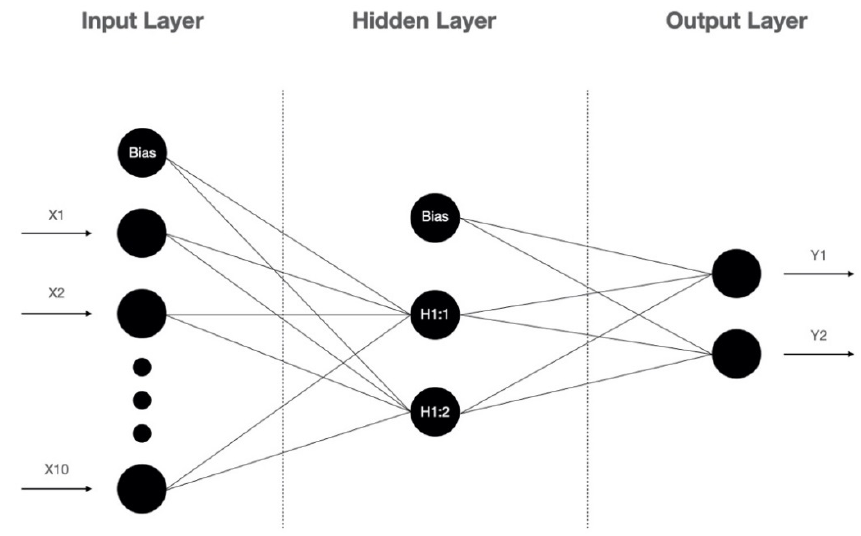
Figure 1. The architecture of the artificial neural network.